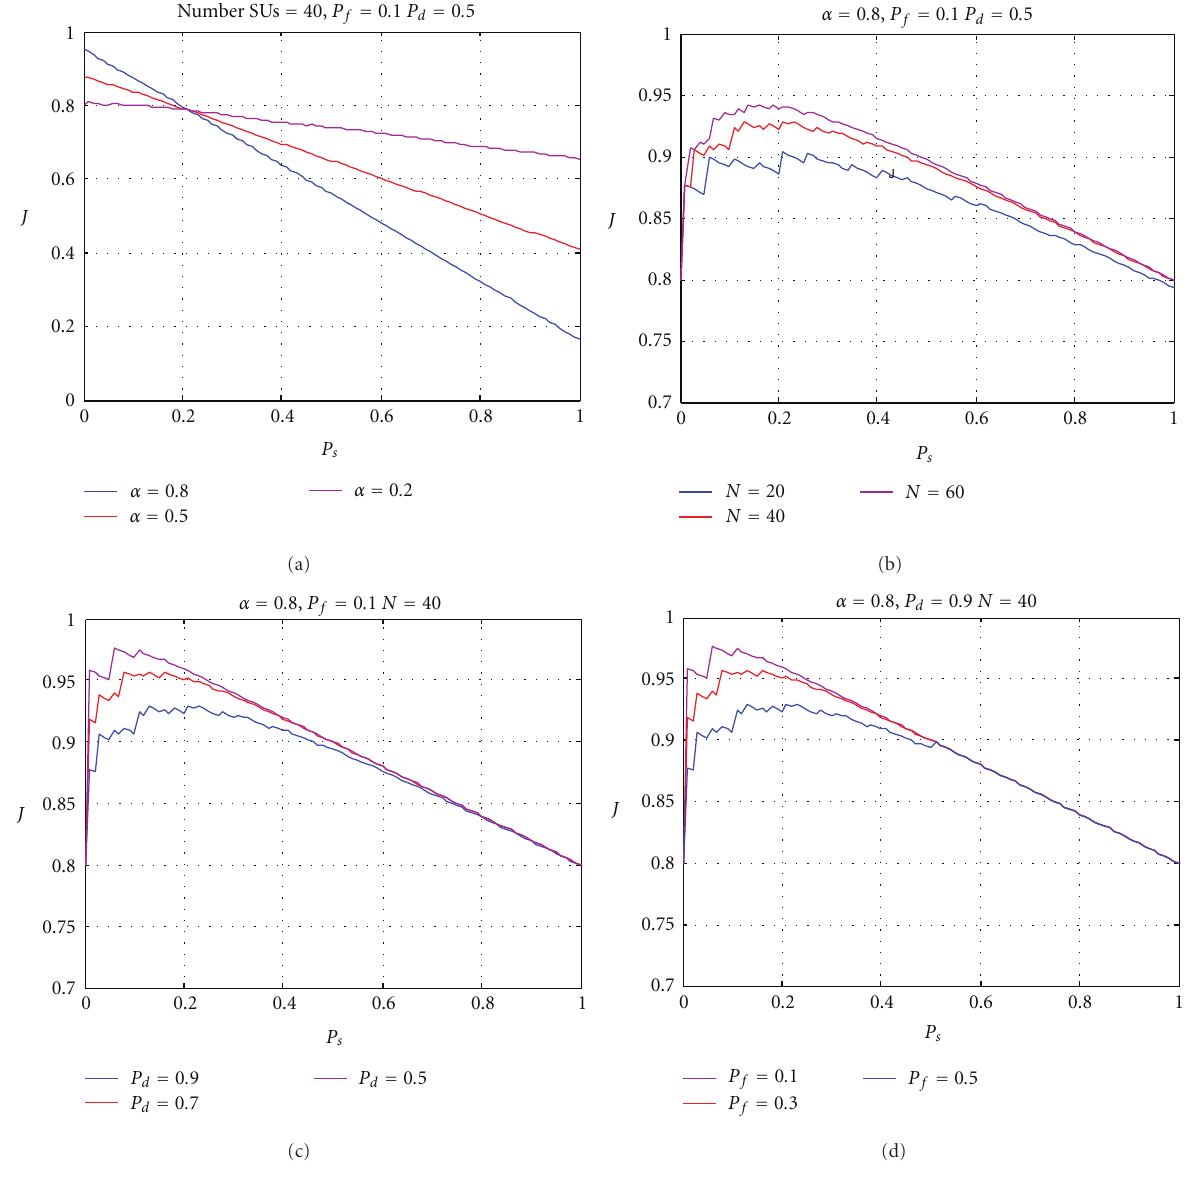
Figure 4: J versus P s